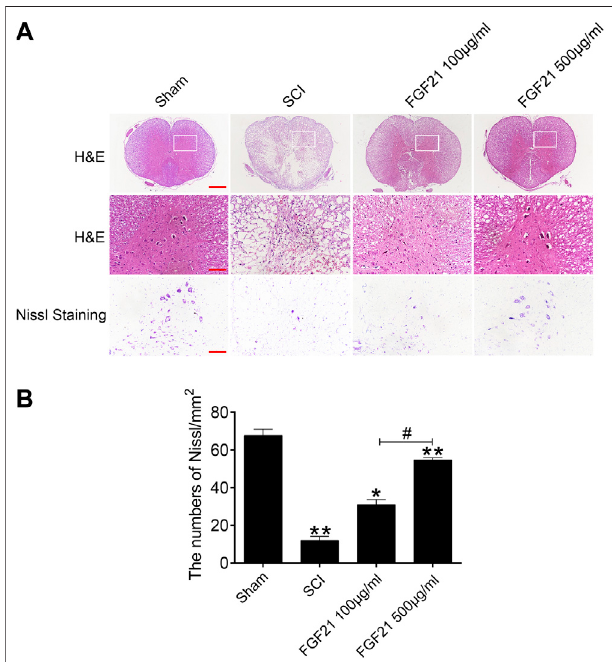
FIGURE3| FGF21treatmentimprovesthetissuestructureandnumberof Nissl bodies (A) Images captured after H&E staining and Nissl staining. The images showed the whole cross section of spinal cord, scale bar (cid:1) 100 μ m. The part restricted by a rectangle represents region with high power images, scale bar (cid:1) 100 μ m. The scale bar of Nissl staining images are 100 μ m (B) Statistical graph of quanti fi cation of Nissl staining data from (A) . Representation ofdata ismean values ± SEM, n (cid:1) 6, “ * ” and “ ** ” represent p < 0.05 or p < 0.01 vs the SCI or Sham group, “ # ” represent p < 0.05 vs the 100 μ g/ml FGF21